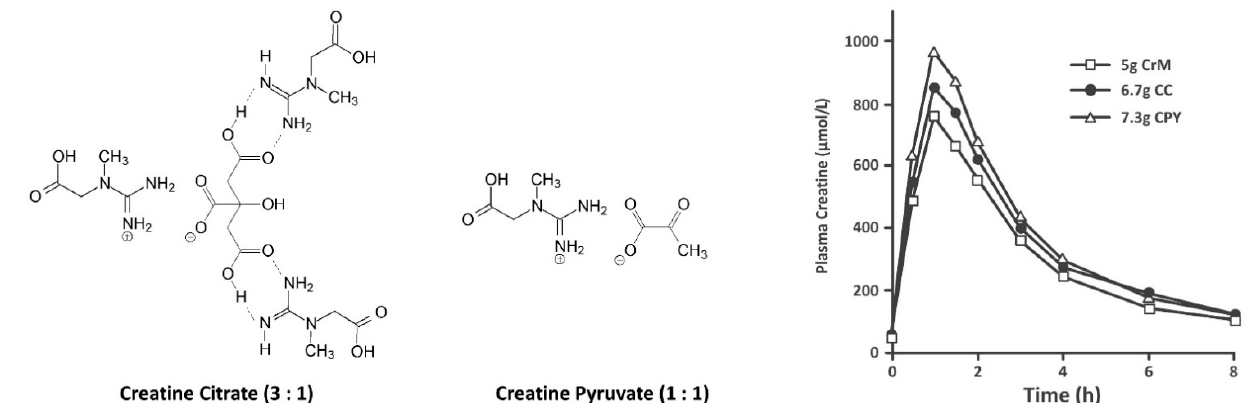
Figure 6. Chemical structure of tri-creatine citrate and creatine pyruvate with plasma creatine changes after oral administration of equal molar doses of creatine monohydrate (CrM), creatine citrate (CC) and creatine pyruvate (CPY). Adapted from Jäger et al. [63].